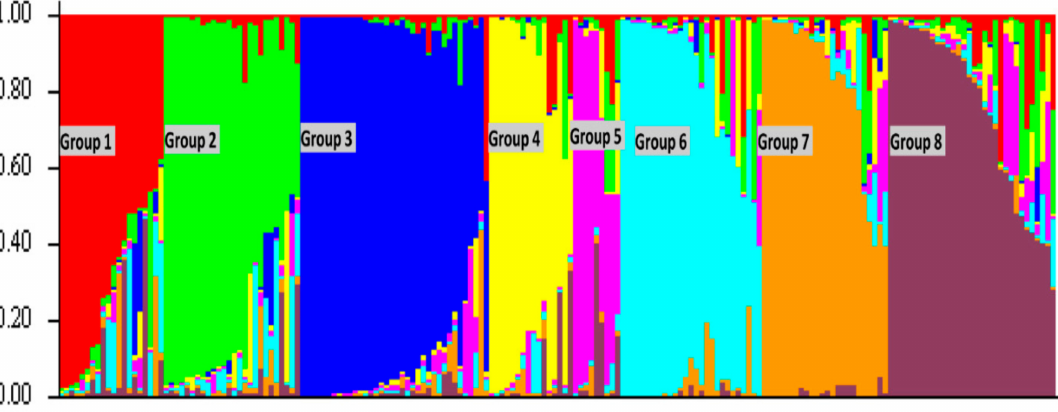
Figure 3. Assignment of US rice germplasms into eight populations using STRUCTURE 2.2 software. The y-axis corresponded to the subgroup membership and the x-axis represented the genotype. The genotypes with the probability of ≥ 70% were assigned to a specific subgroup, while the others were classified as